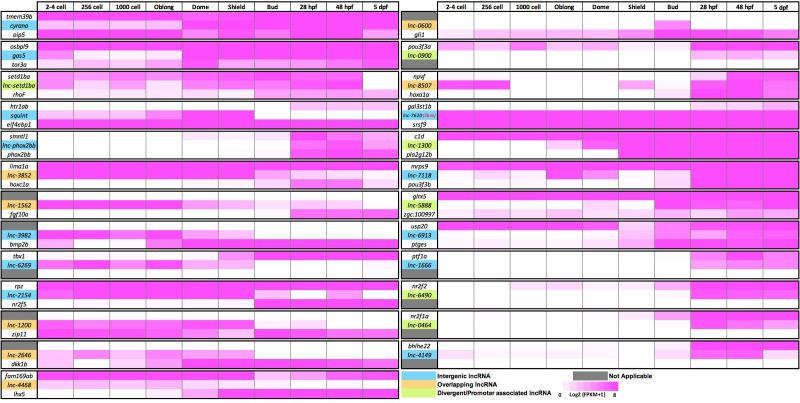
Expression levels of selected lncRNAs and their neighboring protein-coding genes.LncRNAs are color coded as blue (Intergenic), brown (Overlapping) and green (Divergent/Promoter associated) (see Figure 1—figure supplement 1B). For each lncRNA and its upstream (top) and downstream (bottom) neighbor, the expression levels at 10 early-developmental stages are shown (Pauli et al., 2012). The scale is log2 (FPKM +1) value, represented as gradient between 0 (white) and 8 (magenta).